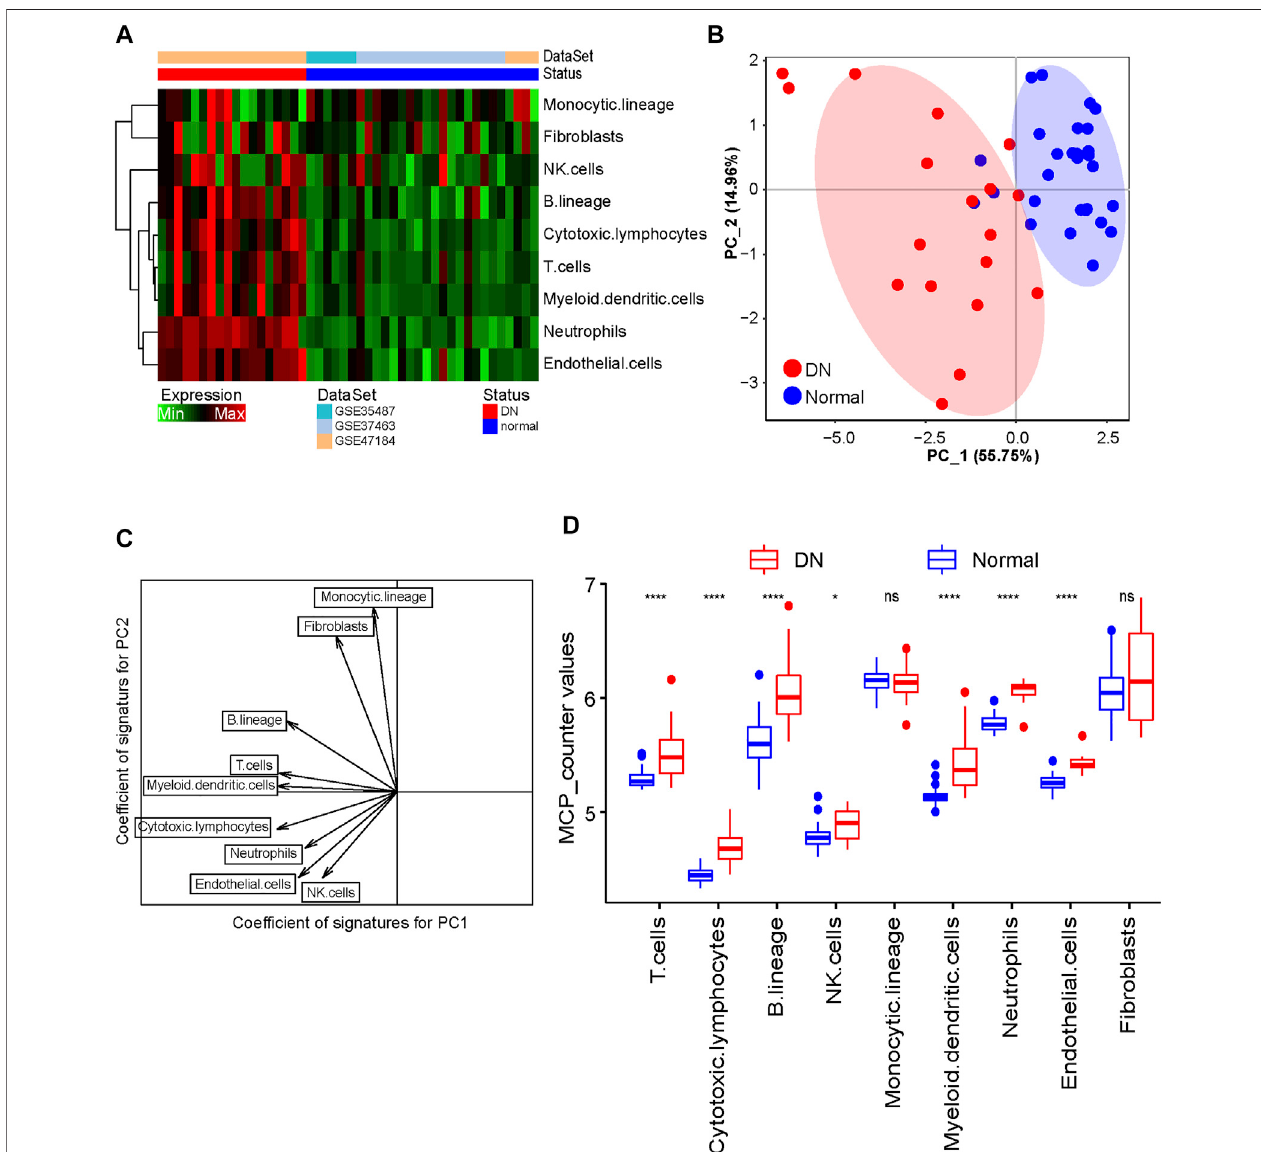
FIGURE2| Evaluation oftissue-in fi ltratingimmuneand stromalcellpopulations. (A) Heatmap showingtheabundanceoftissue-in fi ltratedimmuneandstromal cell populations between DN and healthy samples. (B) PCA fi gure displaying the distribution of DN and healthy samples. (C) Scatter diagram of the vector basis projection showingthecontributiondegreeofcellpopulations. Thelengthofthearrow indicatestheabsolutecontributiondegree. (D) Boxplotshowingtheabundanceofin fi ltrated immune cell populations in DN and healthy samples. The Wilcoxon rank-sum test was used to measure the differences between two groups. Ns, no signi fi cant difference; * p < 0.05; **** p <